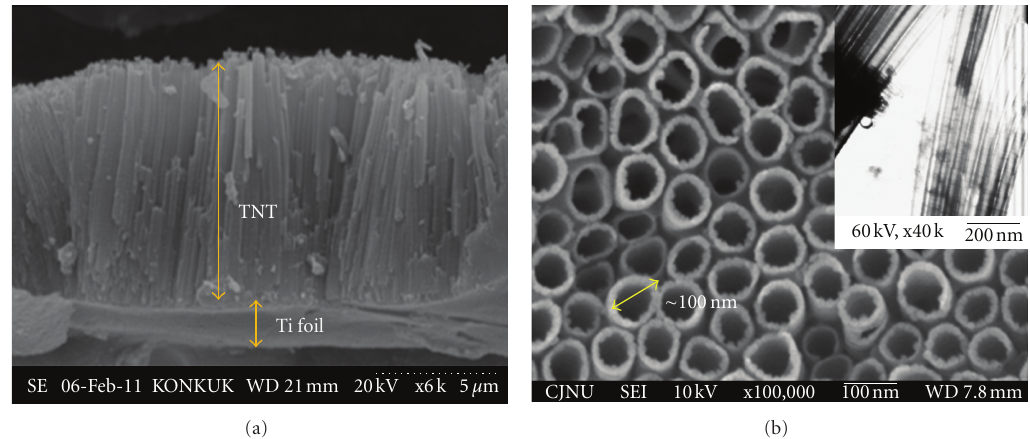
Figure 2: SEM images of TNT arrays by anodic oxidation of electropolished Ti foil at a constant voltage of 70V: (a) cross-sectional image of TNT arrays, (b) top view of the TNT arrays with inset showing the TEM images of TNT.